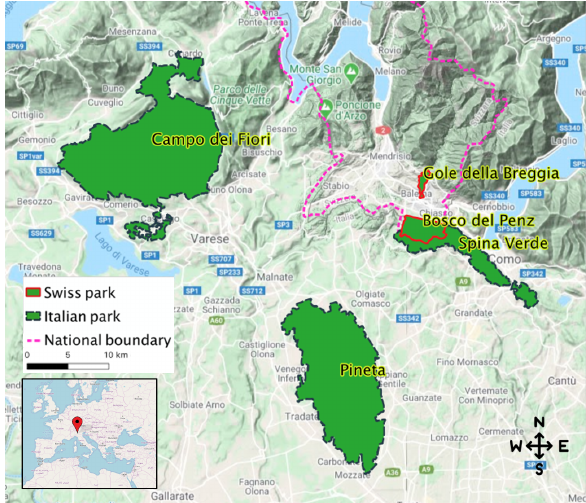
Figure 1. The Insubria region and the natural parks involved in the INSUBRI.PARKS project (basemap: c (cid:13) 2020 Google) the Scuola Universitaria Professionale della Svizzera